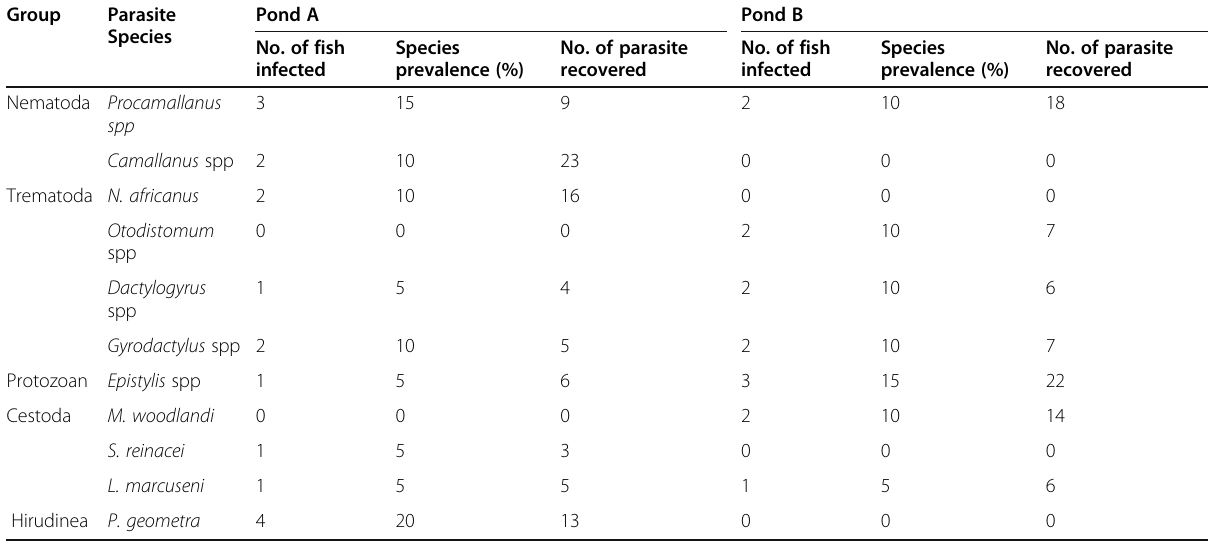
Table 3 Catfish parasites in cultured habitat